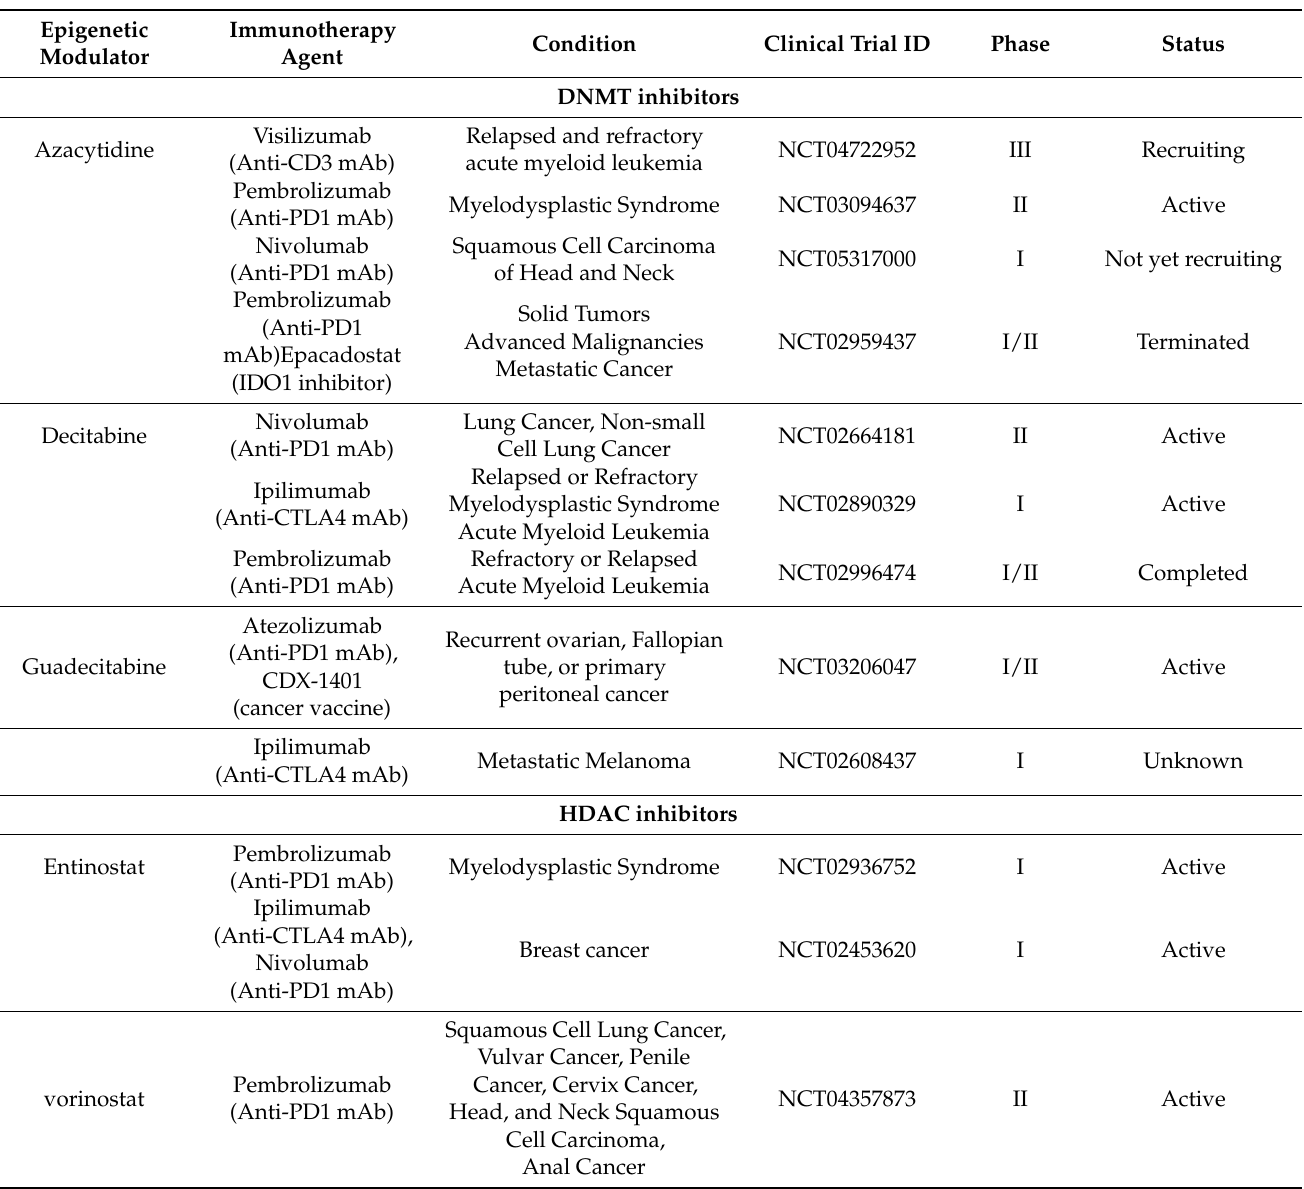
Table 2. Epigenetic modulator in combination with immunotherapy agent for cancer